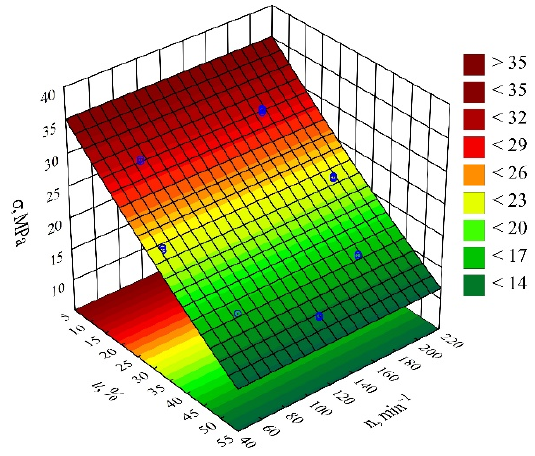
Figure 21. Response surface plot for the tensile strength σ versus wheat bran content u and screw speed n.